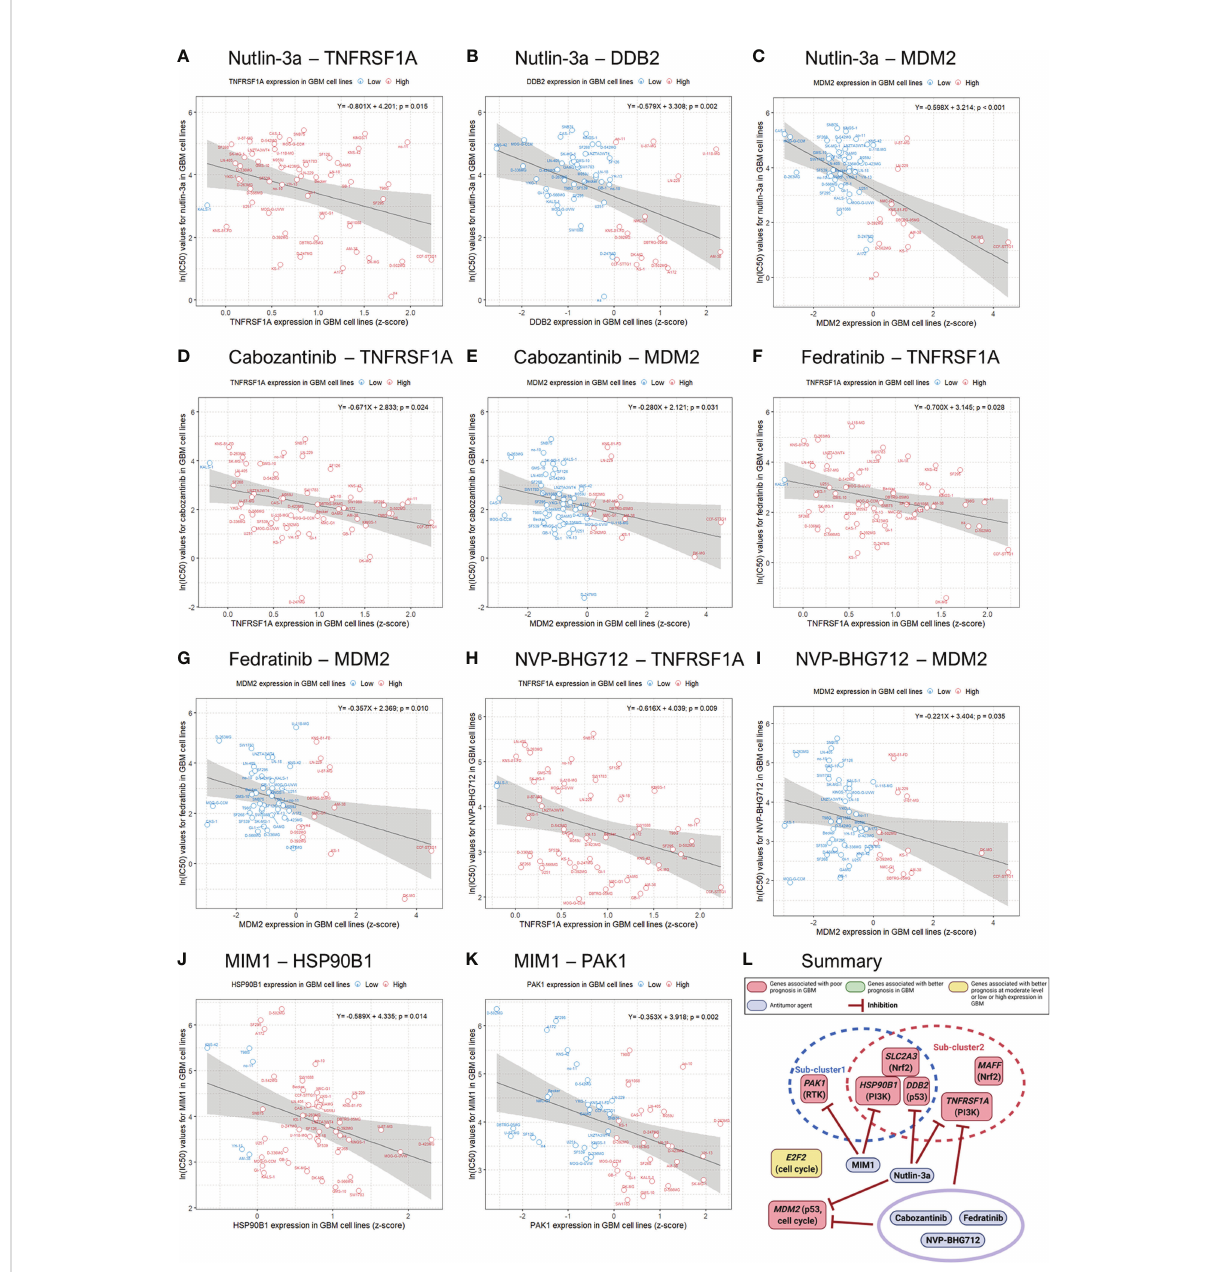
FIGURE 4 Genomics of Drug Sensitivity in Cancer (GDSC) database analysis and an illustration showing actions of antitumor agents on several signi fi cant genes associated with poor prognosis in GBM patients. Linear regression analysis shows associations between gene expression and the natural log of the half-maximal inhibitory concentration [ln(IC50)] values for antitumor agents in 49 GBM cell lines (blue, low gene expression; red, high gene